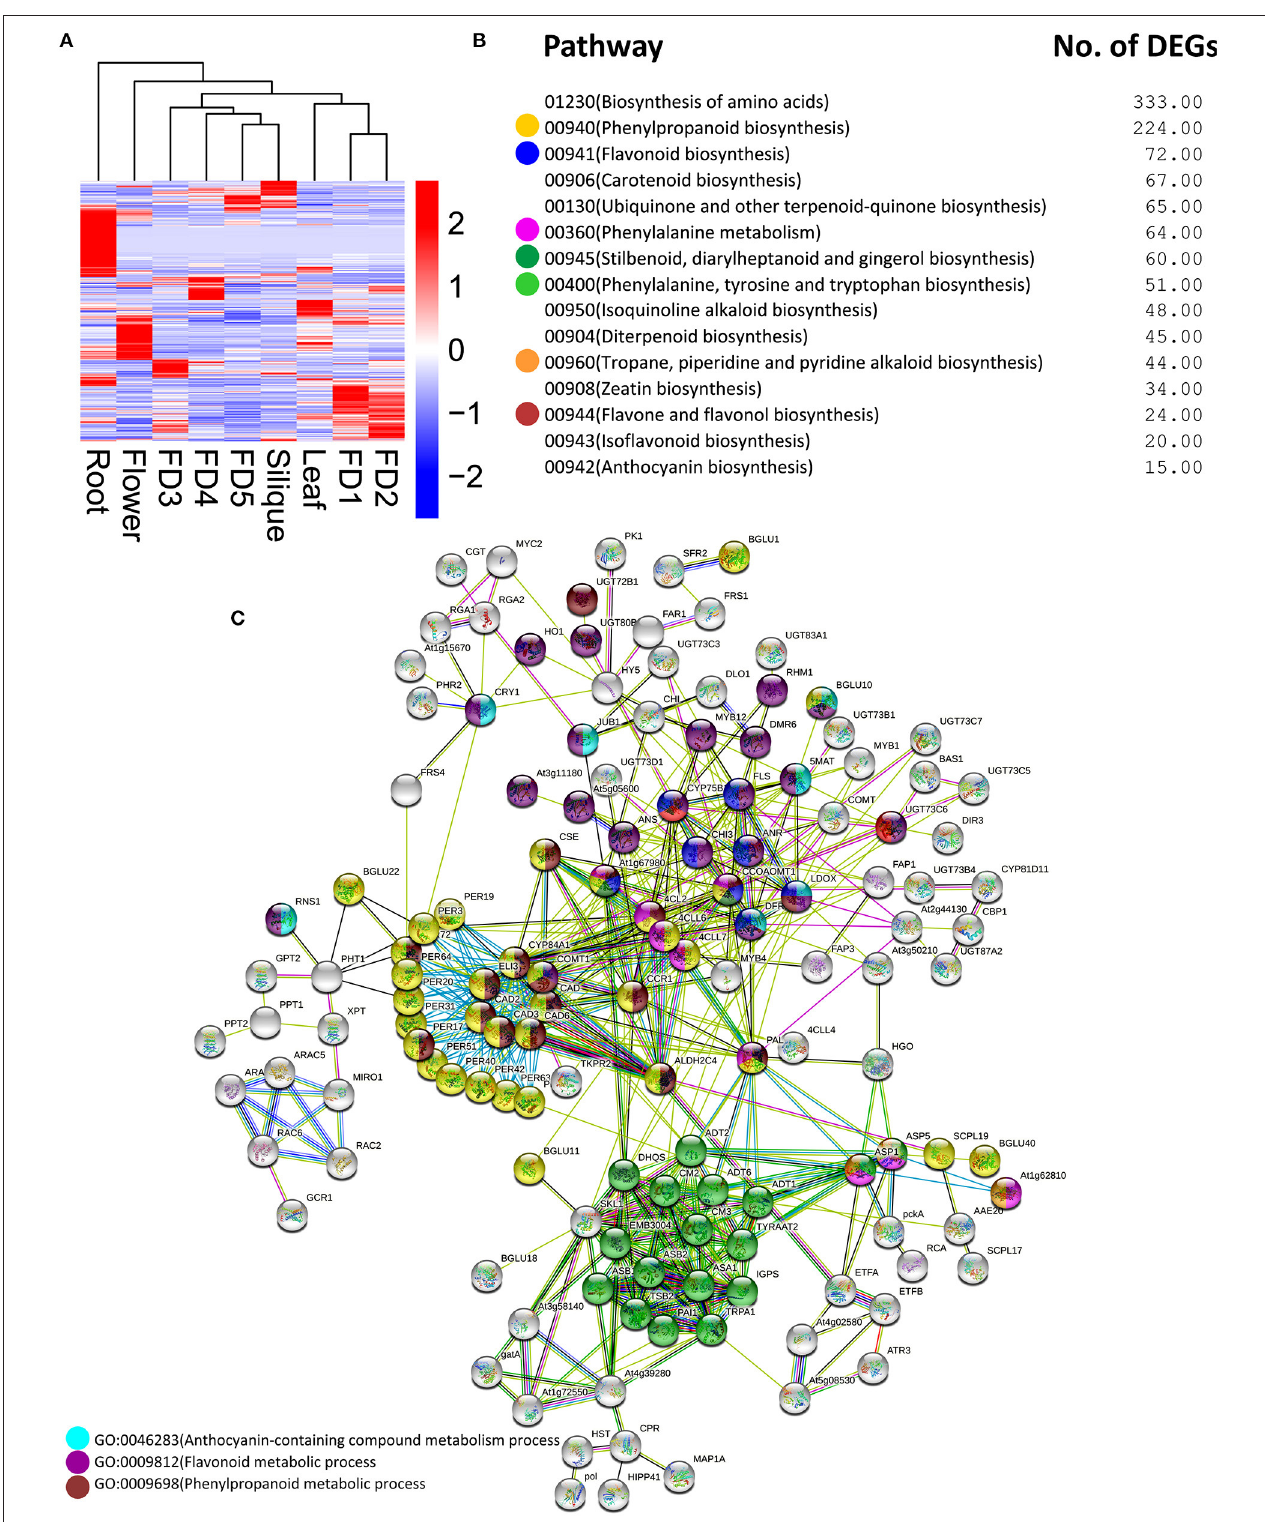
FIGURE 3 | Clustering analysis of DEGs related to secondary metabolites (A) major pathways enriched in DEGs related to secondary metabolites (B) protein–protein interaction among DEGs related to secondary metabolites (C) . The circle colors show the enrichment of pathways shown in part (B) .